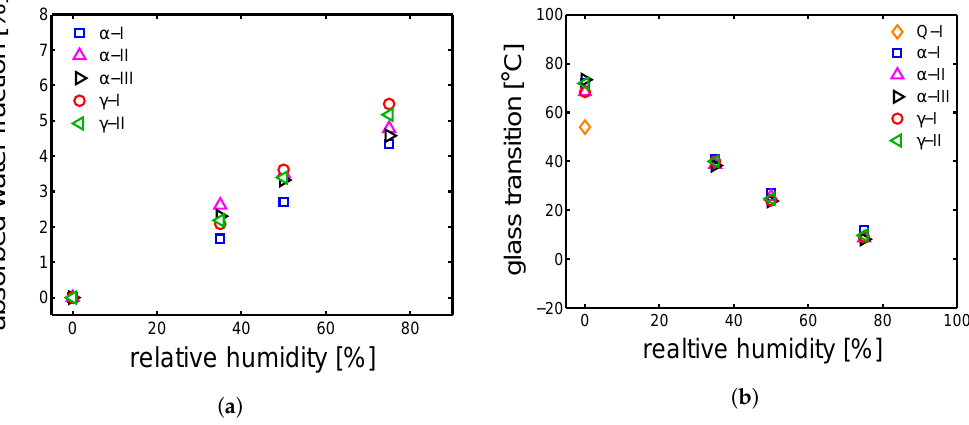
Figure 10. ( a ) absorbed water percentage at saturation in environments with different relative humidity at 23 °C. ( b ) glass transition temperature versus relative humidity.